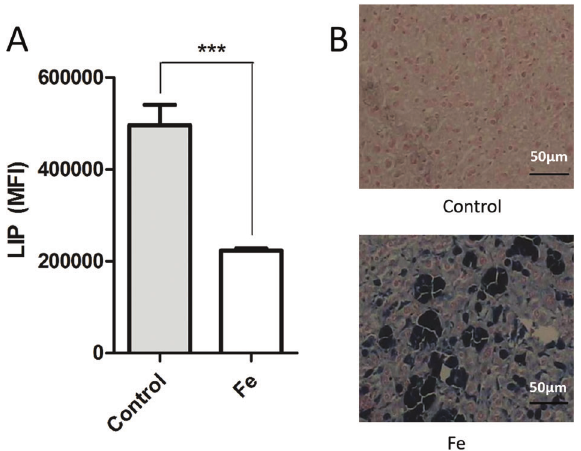
Figure 1. Establishment of an iron overload (Fe) mouse model. A , labile iron pool (LIP) level in bone marrow mononuclear cells after 25 mg/mL iron dextran treatment, mean fl uorescence intensity (MFI). Data are reported as means ± SD. ***P o 0.001, ANOVA. B , Bone marrow analyzed by Perl ’ s iron staining ( (cid:2)